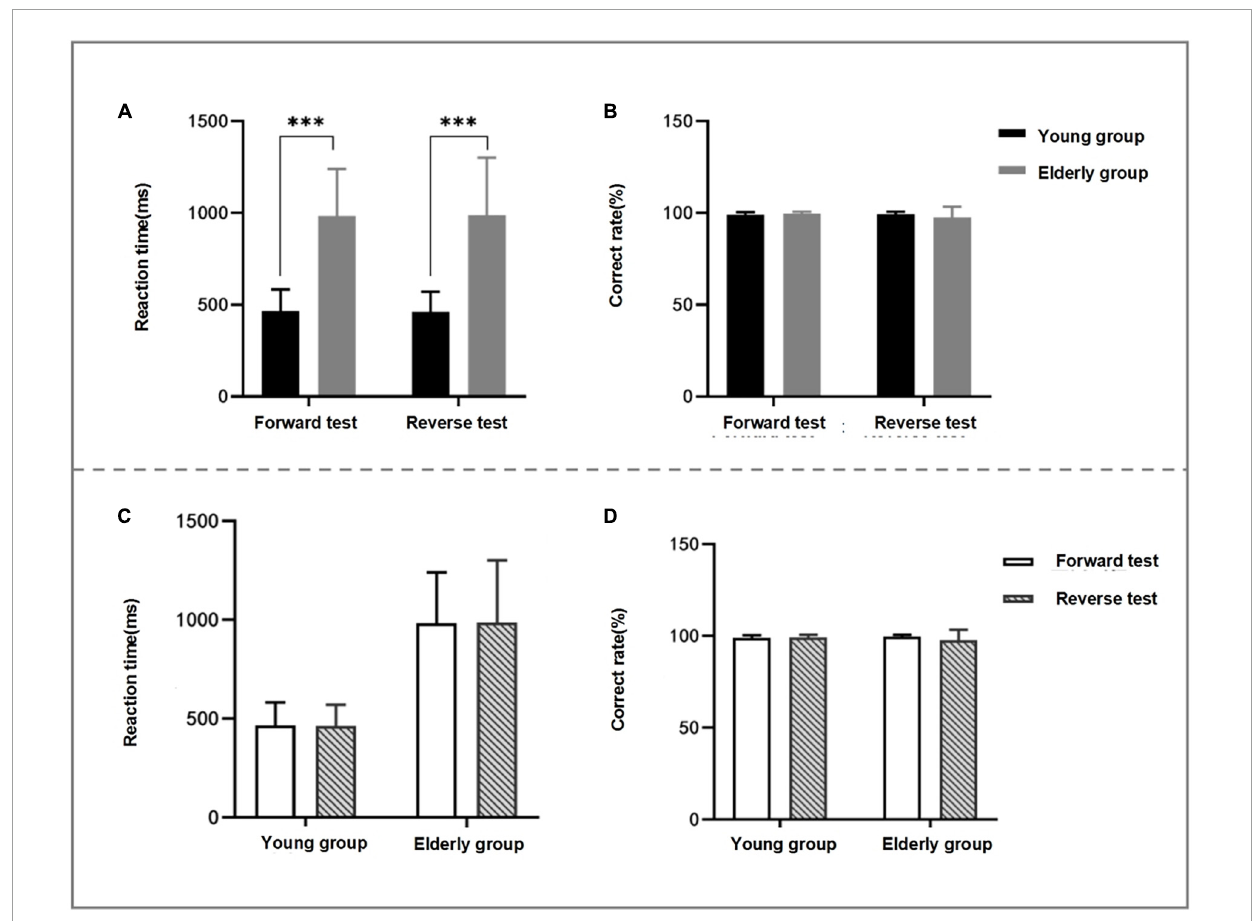
FIGURE3 Comparison between groups and within groups of behavioral data of two groups of subjects’ judgment test. (A,B) Are the comparison between two groups of subjects’ judgment test behavior data, panel (A) is the comparison between groups at reaction time, and panel (B) is the comparison between groups at correct rate. (C,D) Shows the intra-group comparison of behavioral data of two groups of subjects’ judgment test, panel (C) is the intra-group comparison of reaction time and panel (D) is the intra-group comparison of correct rate; as can be seen from panel (A) , the reaction time of the elderly group is significantly longer than that of the young group in the forward and reverse judgment tests ( P < 0.05). ∗ P < 0.05; ∗∗ P < 0.01; ∗∗∗ P <